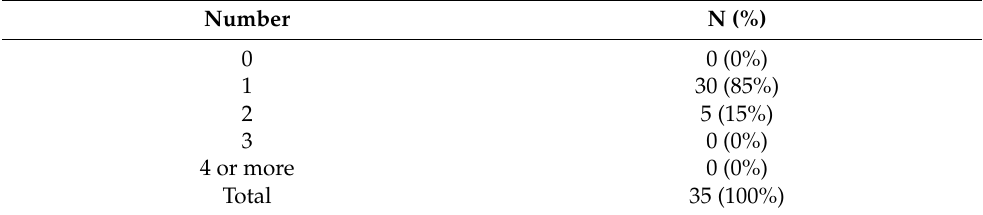
Table 2. Number of stents implanted.